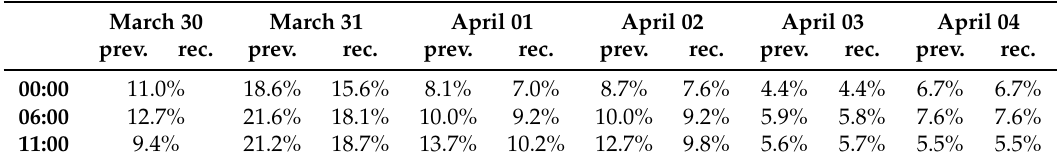
Table 9. Error values for evaluation of the most recent models of the respective day and the evaluation of their respective direct predecessors all normalized to the largest value measured during the six days of the second test period and calculated for the time interval from the forecast calculation until